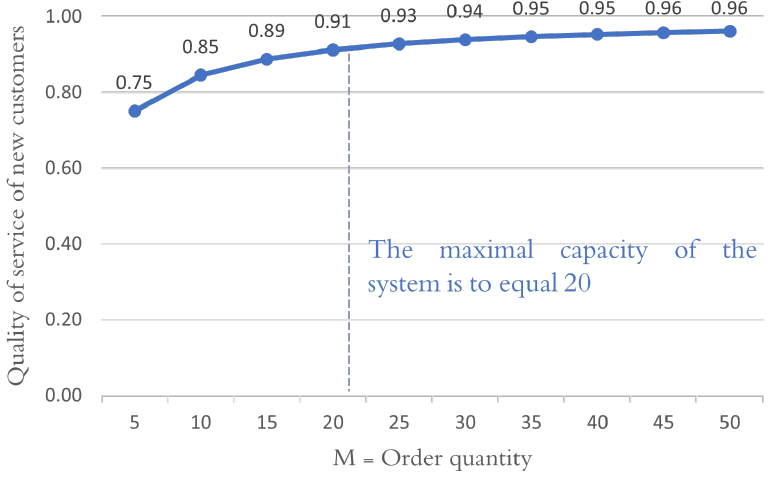
Figure 6. Effect of changing the order quantity with respect to the quality of service of new customers under a uniform order